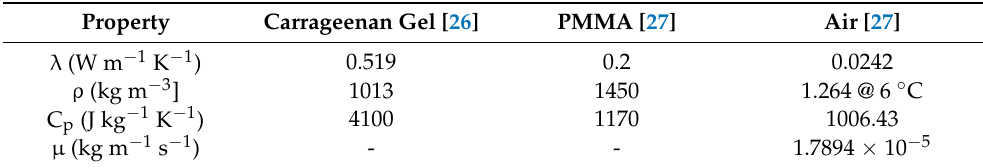
Table 1. Thermophysical properties used for the heat transfer modelling.